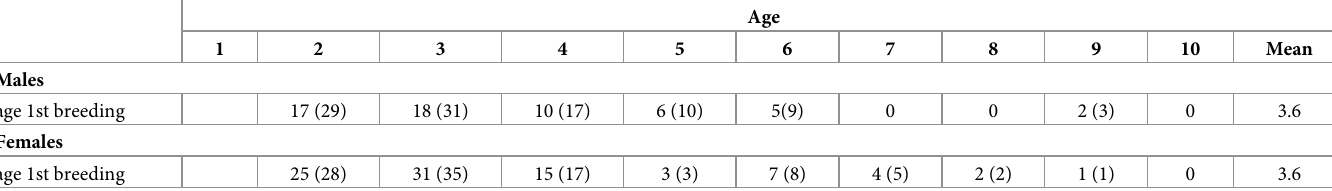
Table 3. Number of individuals by age (number of full years since hatch) at first breeding (%) for 58 male and 88 female northern goshawks of known-age in Ari- zona, USA, 1991–2010.